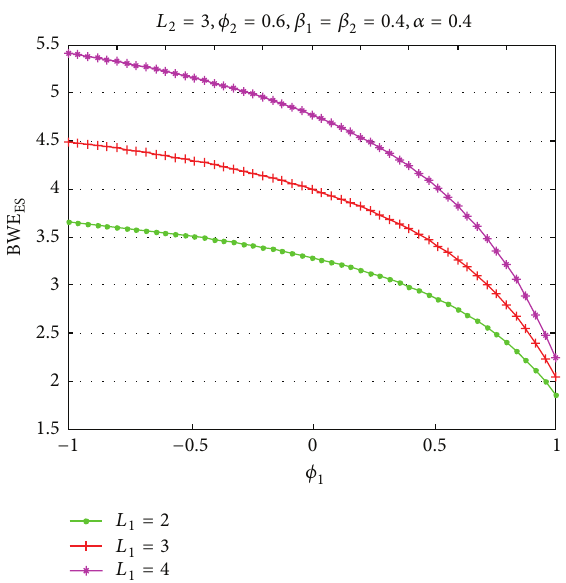
Figure 12: Impact of 𝛼 on bullwhip effect for different 𝛽 1 under the ES.